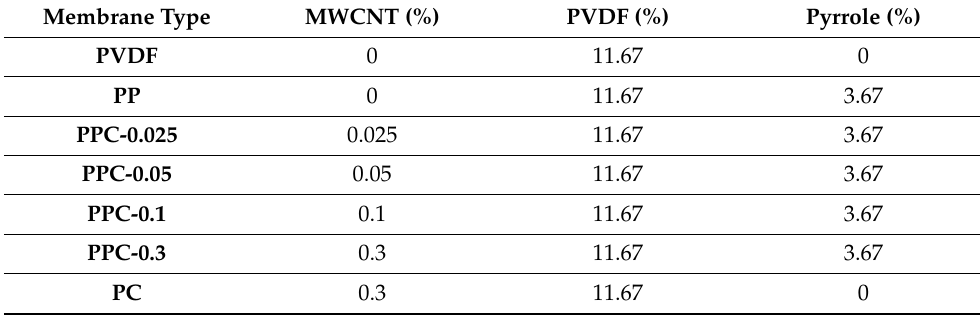
Table 1. Compositions of different fabricated membranes.